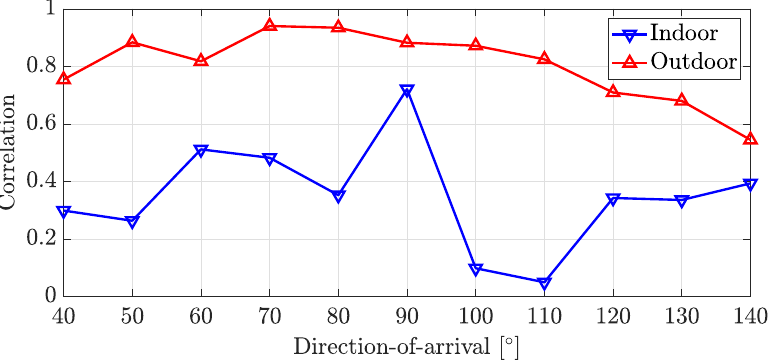
Figure 4. Correlation between collected covariance matrices and ideal covariance matrices according to DoA and experiment